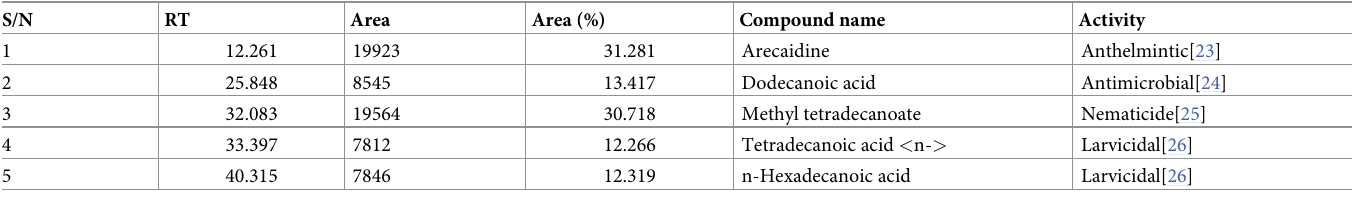
Table 2. Chemical compounds for Areca catechu